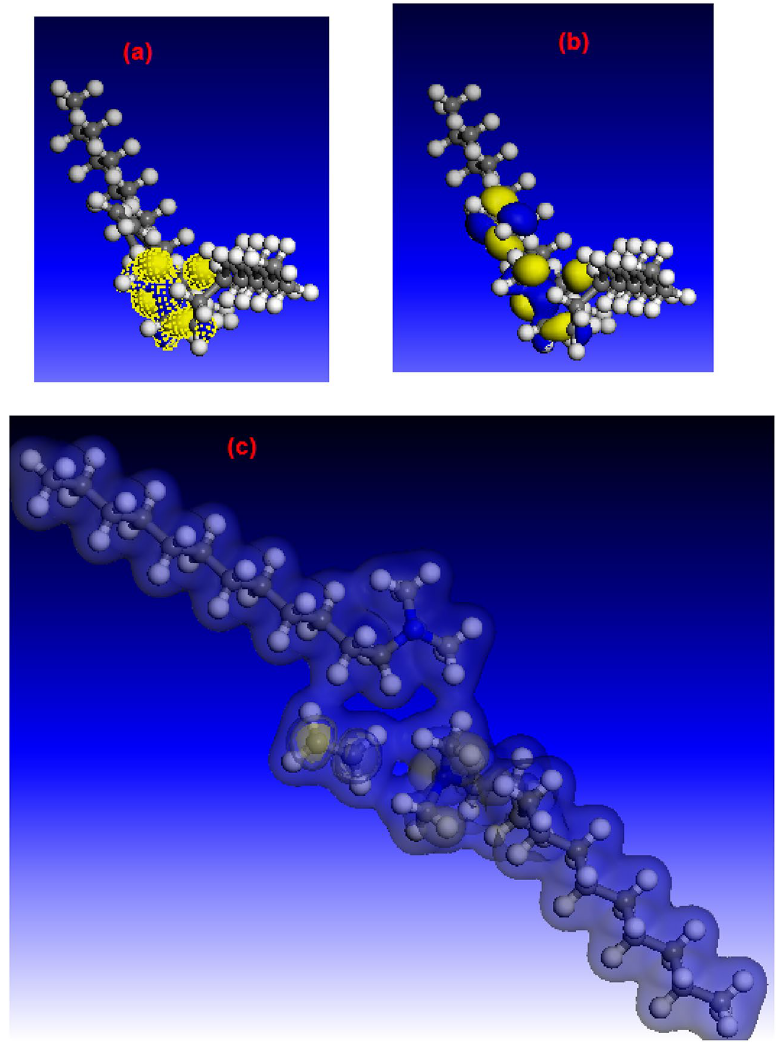
Figure 11. ( a ) HOMO, ( b ) LUMO and ( c ) total electron density distribution for DMAEB molecule. "Computational results obtained using software programs from Accelrys Software Inc. The ab initio calculations were performed with the DMol 3 program, and graphical displays generated with Materials